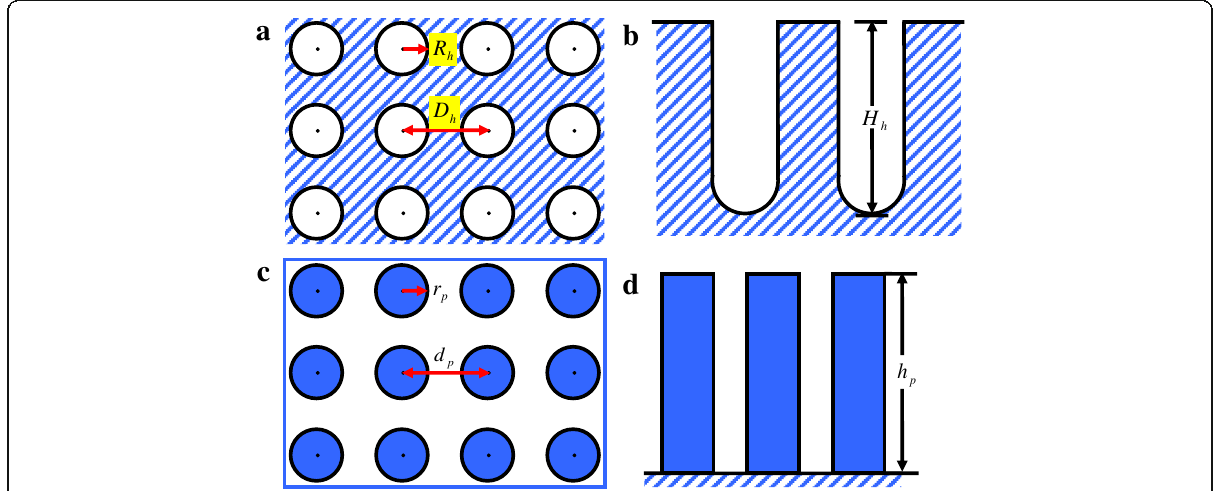
Fig. 1 Schematic depiction of a surface decorated with a regular array of nanoholes and nanopillars. Plan view of a surface textured with a regular array of nanoholes of radii, R h , and center-to-center spacing, D h ( a ). Side view of a surface textured with a regular array of nanoholes of height, H h ( b ). Plan view: the radii and center-to-center spacing of nanopillars are r p and d p , respectively ( c ). Side view: the height of nanopillars is h p ( d